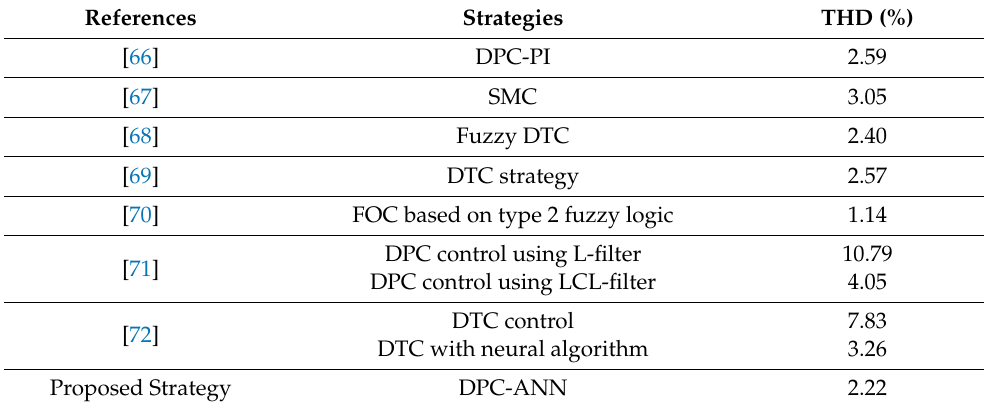
Table 5. Comparison between the intelligent DPC strategy and those utilized in some existing